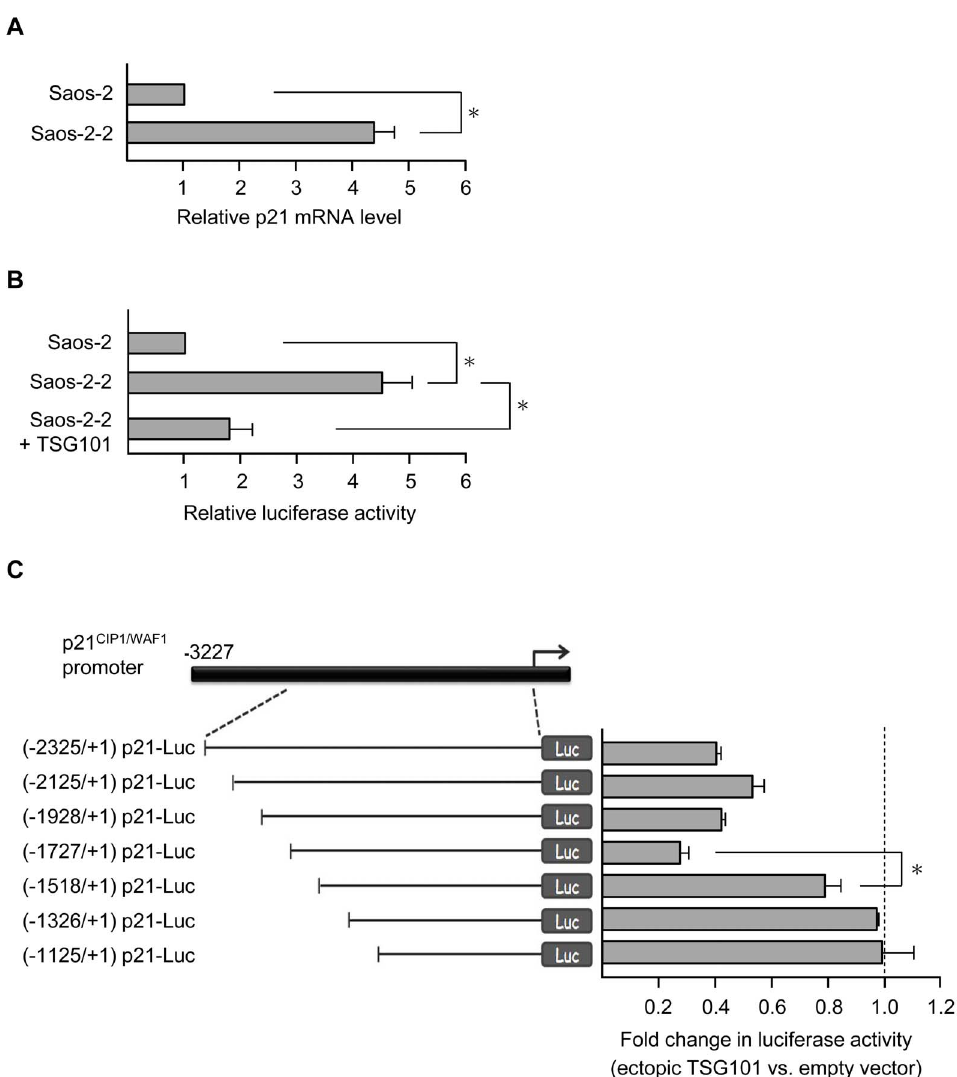
Figure 1. Stable TSG101 knockdown cell lines show increased p21 CIP1/WAF1 expression. (A) p21 mRNA levels in Saos-2 and Saos-2-2 cells were assessed by real-time quantitative RT-PCR. Transcripts were normalized to b -actin, and the p21 mRNA level in Saos-2 cells was set to 1. Saos-2-2 stable line shows 4.3 6 0.5 in relative p21 mRNA level. (B) p21 promoter activity was examined by luciferase reporter assay. Cells as indicated were transfected with the (-3227/ + 1) p21-Luc construct, in which the firefly luciferase gene is driven by the p21 promoter. Luciferase activities were measured and normalized to b -gal, and the activity in parental Saos-2 cells was set as 1. Relative luciferase activities of Saos-2-2 (4.5 6 0.55) or of Saos- 2-2 cells expressing ectopic TSG101 (1.8 6 0.4) are shown. (C) Left, schematic diagram of reporter constructs with a series of p21 promoter deletions. The transcription start site is indicated by the rightward arrow in the top panel and numbered + 1. Right, effect of TSG101 on promoter activity of p21 deletion constructs. Saos-2-2 cells were transfected with individual reporter plasmid together with an empty vector or a TSG101 expression construct pcDNA-SR a /HA-TSG101. The ratio of luciferase activity in cells with or without ectopic TSG101 expression is shown. Data presented are means 6 s.d. of three independent experiments (* P , 0.05, Student’s t